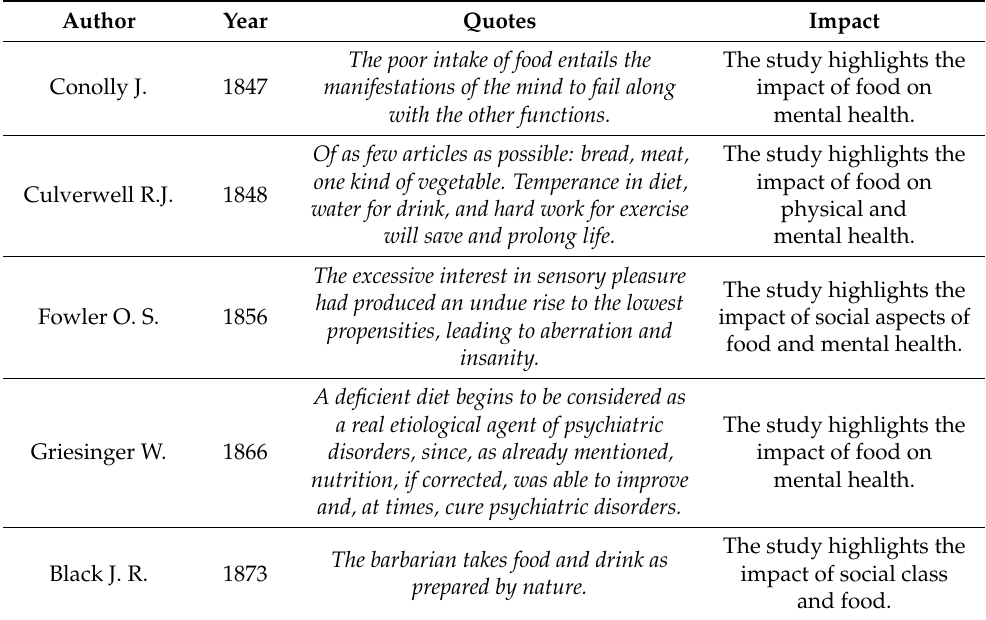
Table 1. Eureka moment. Links between diet and health (Conolly 1847; Culverwell 1848; Fowler 1856; Griesinger 1866; Black 1873; Foucault